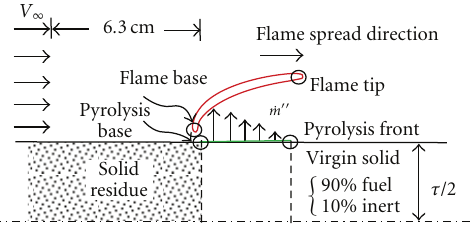
Figure 1: Configuration of a spreading flame in the computational